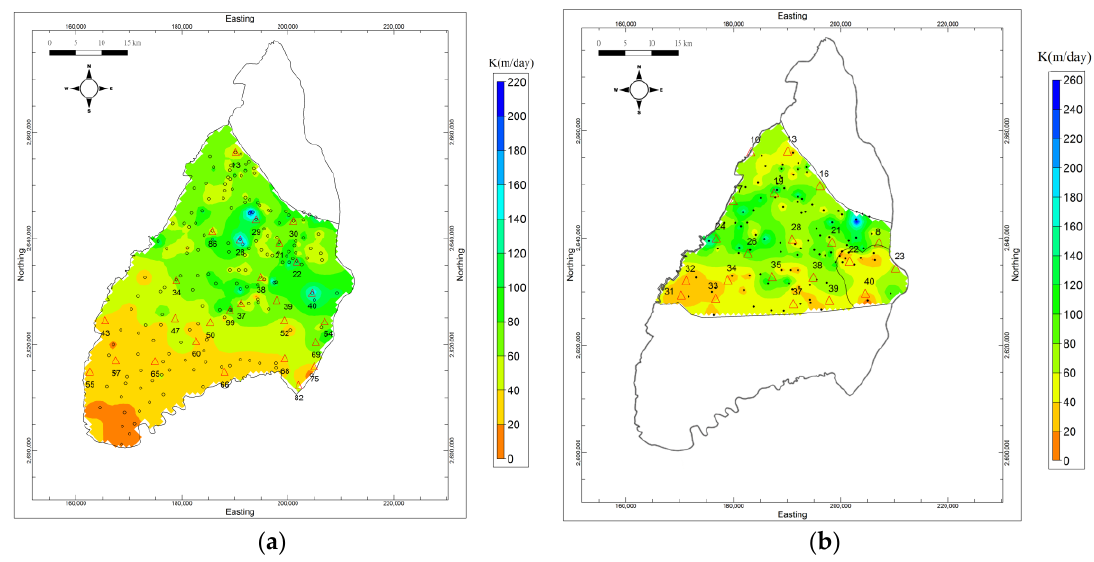
Figure 10. K fields of zone1 to zone 5 derived from the proposed method. ( a ) K fields of zone 1, zone 2, and zone 5. ( b ) K fields of zone 3 and zone 4.